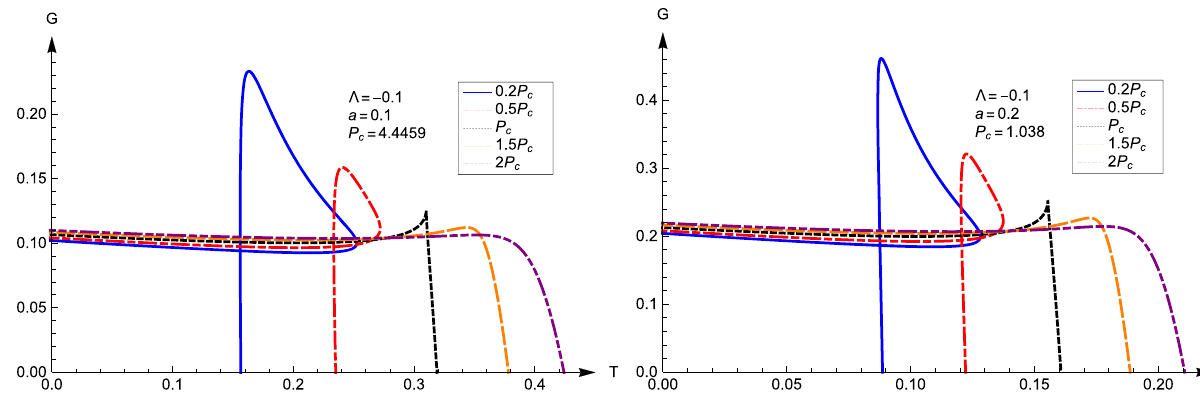
Fig. 8 Gibbs free energy versus T for (cid:2) = − 0 . 1 and a = 0 . 1 (left panel), and (cid:2) = − 0 . 1 and a = 0 . 2 (right